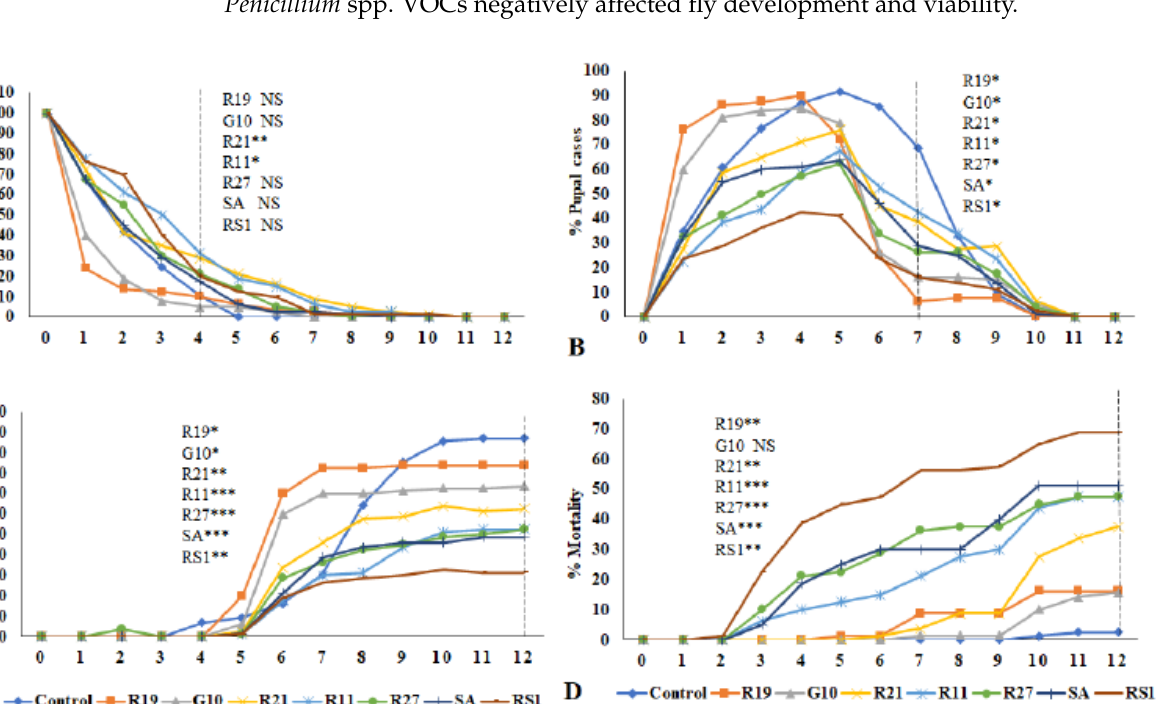
Figure 5. Development and viability of Drosophila larvae exposed to VOCs emitted by Penicillium species. The percentages of living larvae ( A ), pupae ( B ), living adults ( C ), and dead flies ( D , E ) are shown. Asterisks (*) indicate significant difference from control (* p < 0.05, ** p < 0.005, *** p < 0.0005). NS denotes not significant, and N = 90. Dashed vertical lines denote the